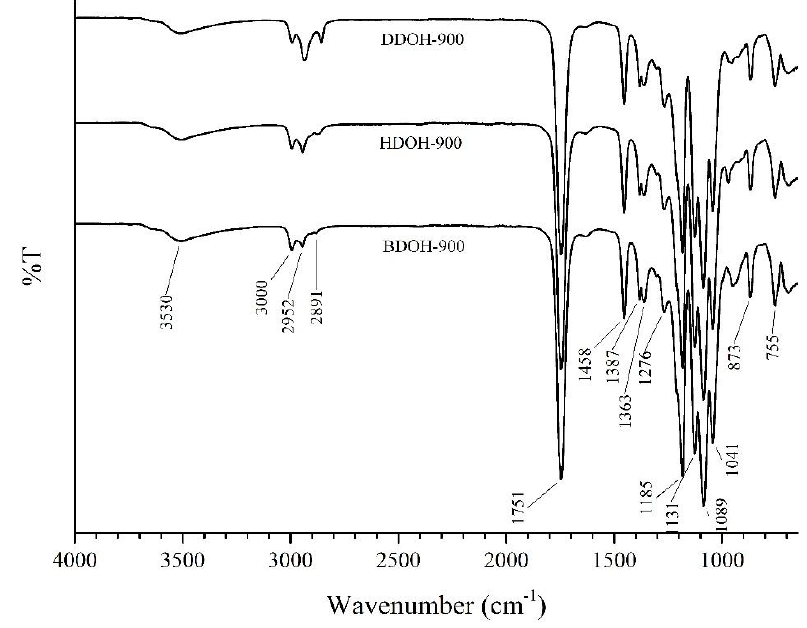
Figure 2. FTIR spectra of BDOH-900, HDOH-900, and DDOH-900.